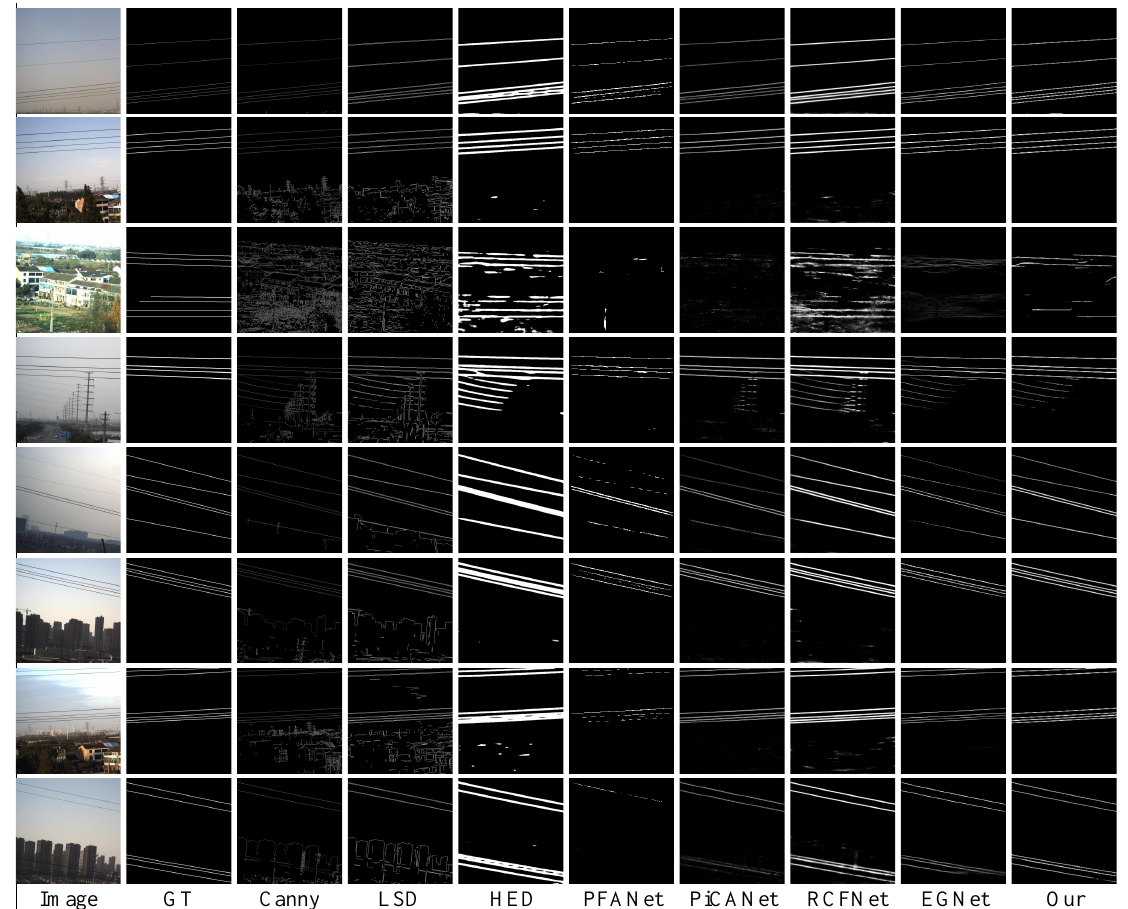
Figure 10. Comparison of power line detection results on the PLAD